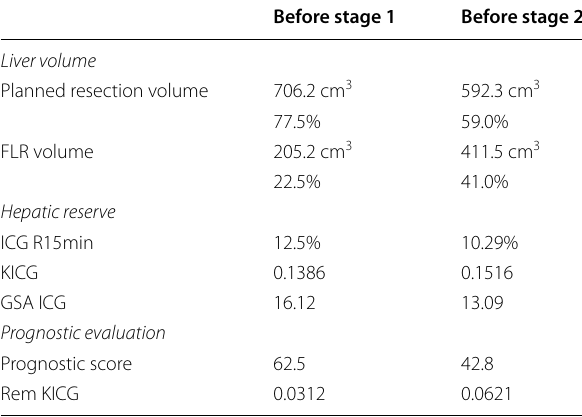
Table 1 Changes in liver volume and hepatic